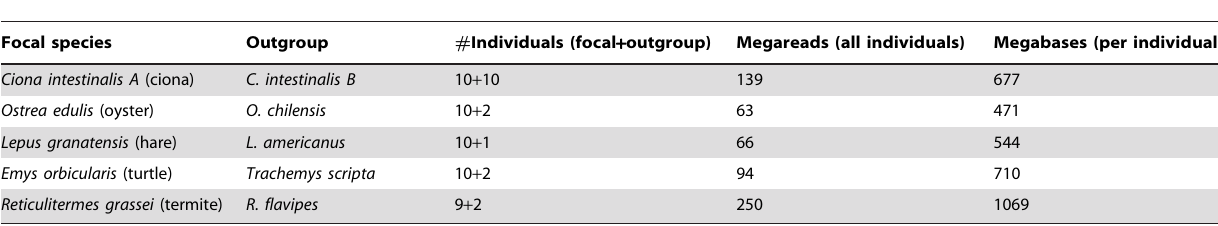
Table 1. Illumina data sets used in this